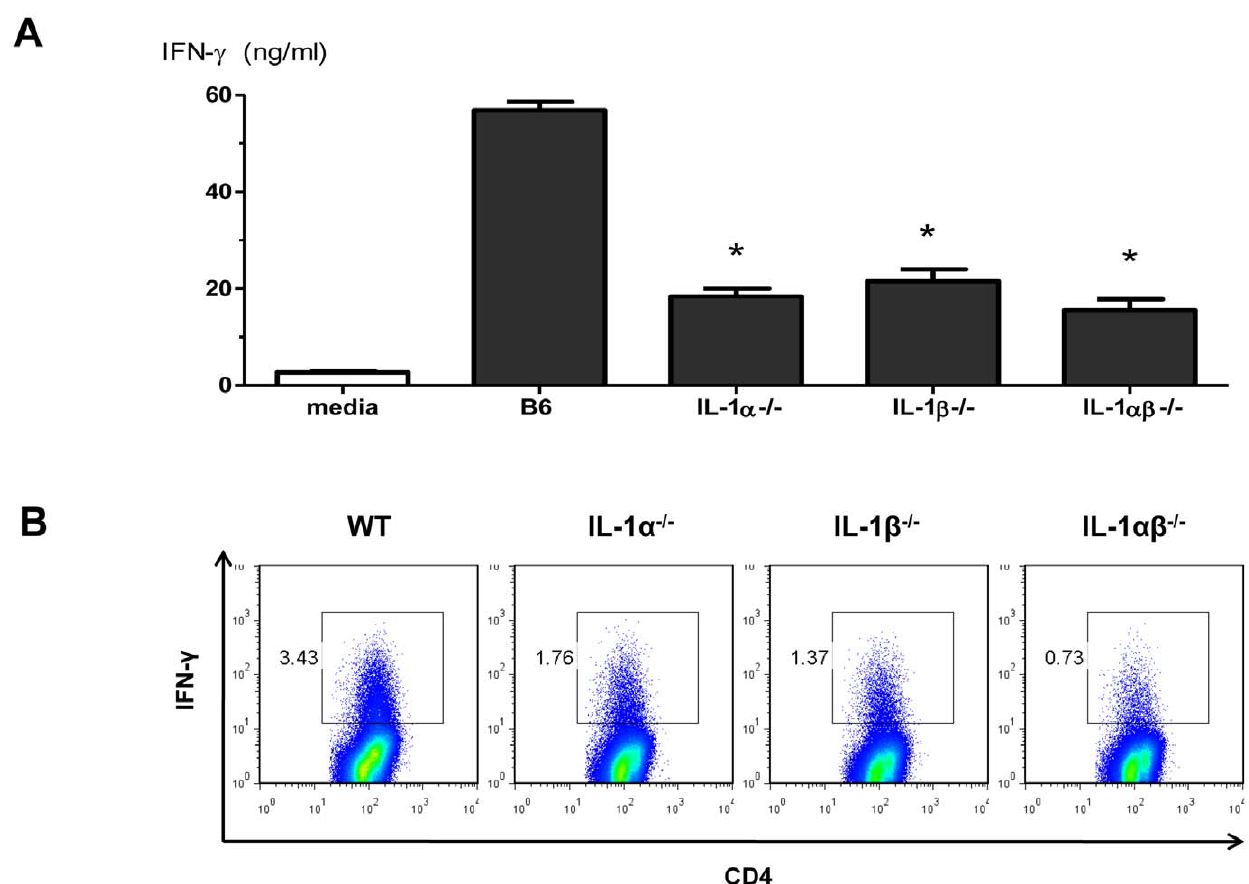
Figure 4. IL- 1 a and IL-1 b are essential for R-848 stimulation of CD4 + Th1 responses. (A) Cell culture supernatant IFN- c levels (day 6) in MHC congenic MLRs utilizing B6, IL-1 a 2 / 2 , IL-1 b 2 / 2 or IL-1 ab 2 / 2 cDCs. Values are mean 6 SEM (n=2). *p , 0.05 compared to R-848 stimulated B6 cDC MLR. (B) ICS staining for IFN- c producing CD4 + T-cells in MHC congenic MLRs utilizing B6, IL-1 a 2 / 2 , IL-1 b 2 / 2 or IL-1 ab 2 / 2 cDCs (representative of two independent experiments shown). Values shown are the % of IFN- c + conventional CD3 + CD4 + T-cells. we added mouse rIL-1 a and rIL-1 b at the same time as poly I:C in MHC congenic MLRs. Addition of IL-1 a and IL-1 b increased poly I:C induced cytokine-producing (IFN- c , TNF- a and IL-2) CD4 + T-cells (Figure 6). The data indicated that early IL-1 a and